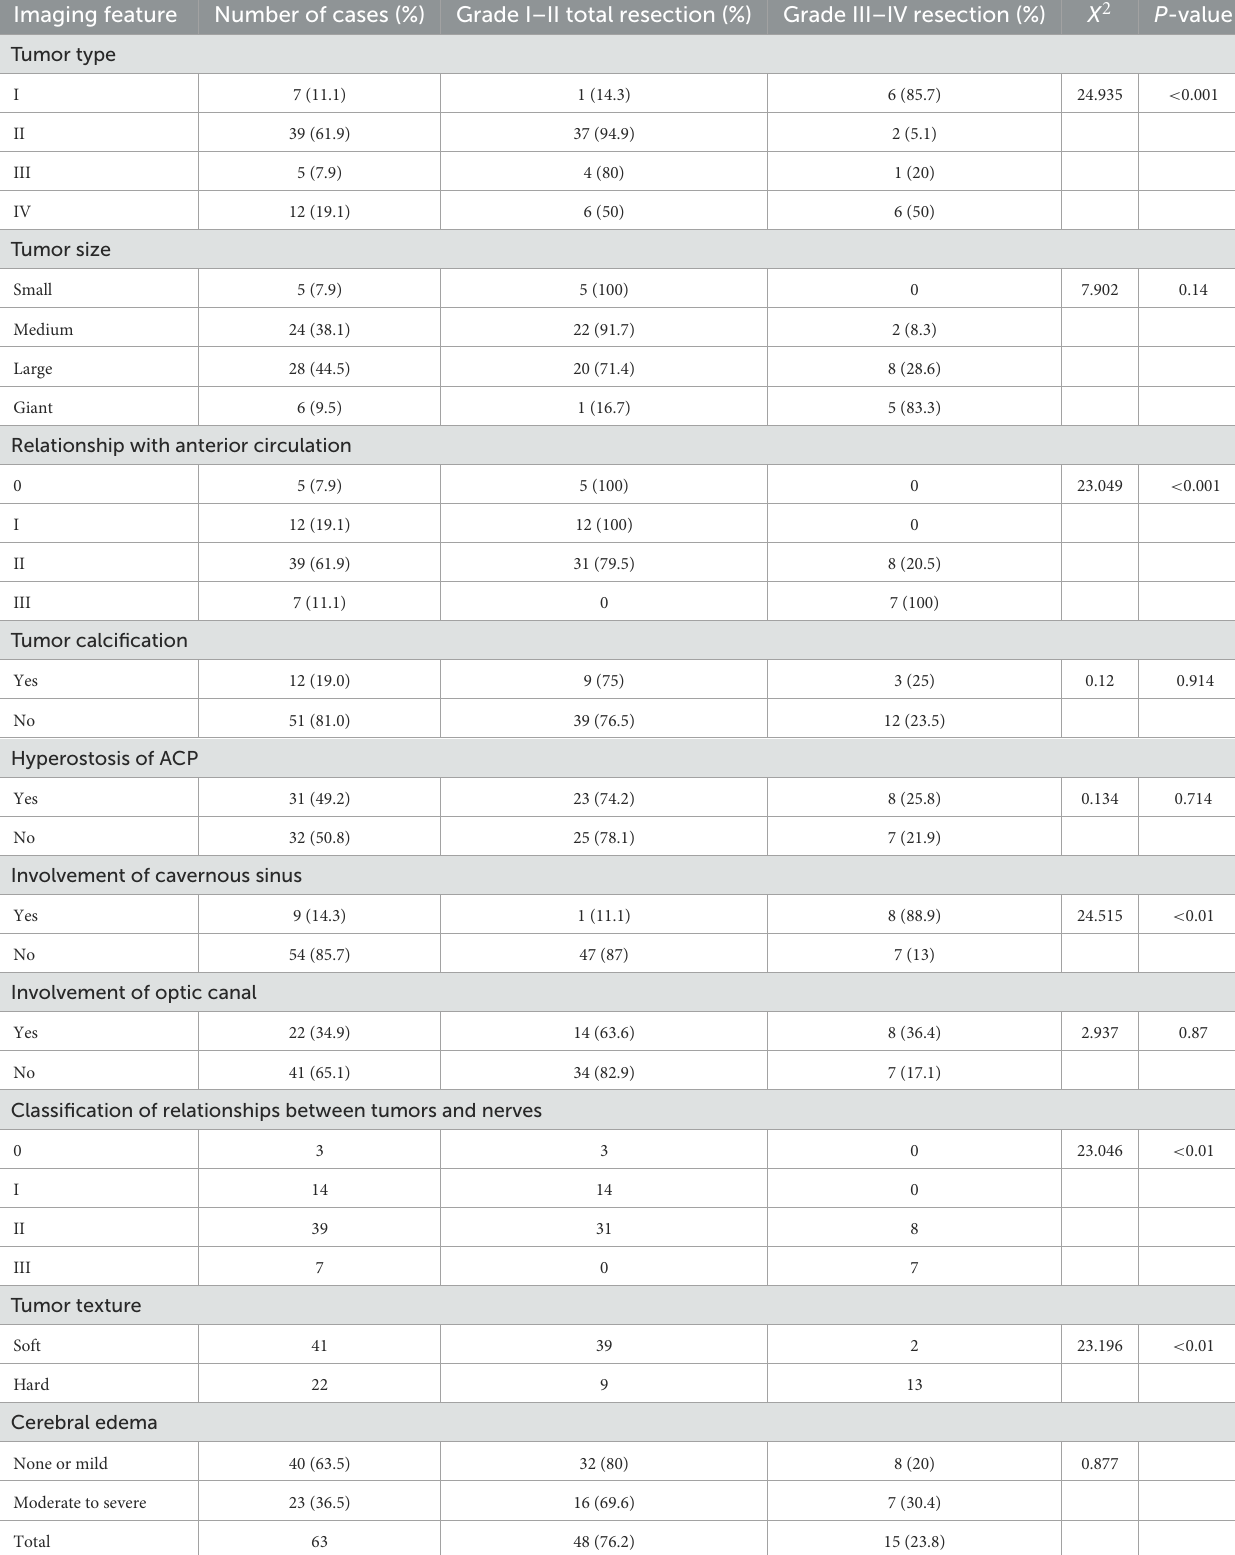
TABLE 2 Relationships between imaging features and extent of tumor resection in 63 cases of ACMs. Imaging